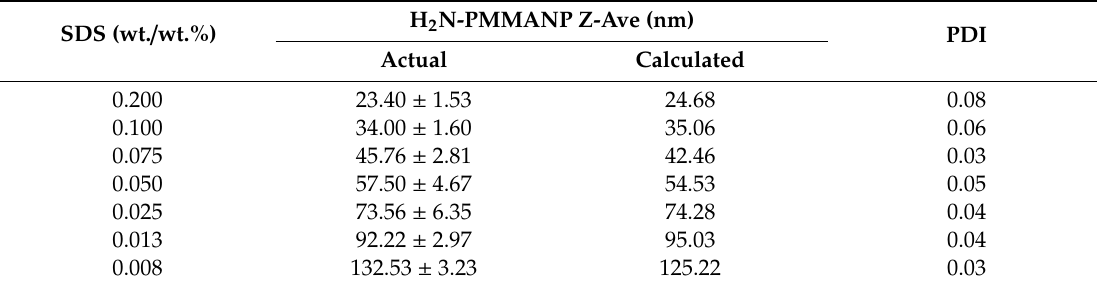
Table 2. Actual vs. Formula-calculated Sizes of H 2 N-PMMANPs. SDS (wt. /